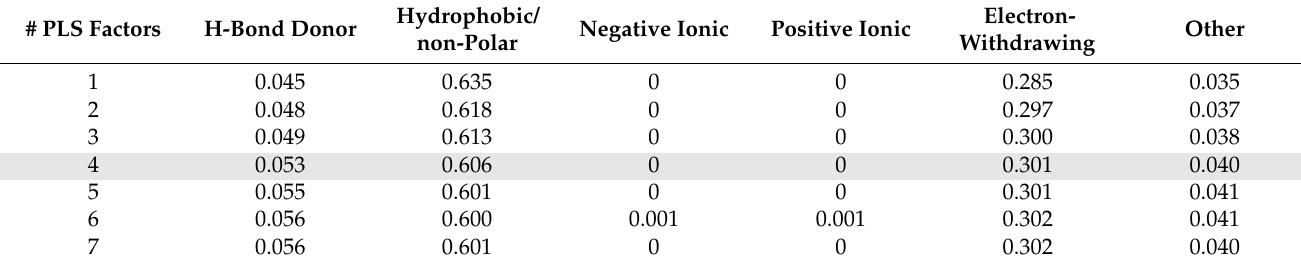
Table 3. Distribution of atom types of the generated QSAR model. Listed are numbers of partial least squares factors of the regression model (# PLS factors), the relative proportions to the model of H-bond donor, hydrophobic (= non-polar), negative ionic, positive ionic, electron-withdrawing, and other atom types. The data for four PLS factors are highlighted since this model was used for VS.